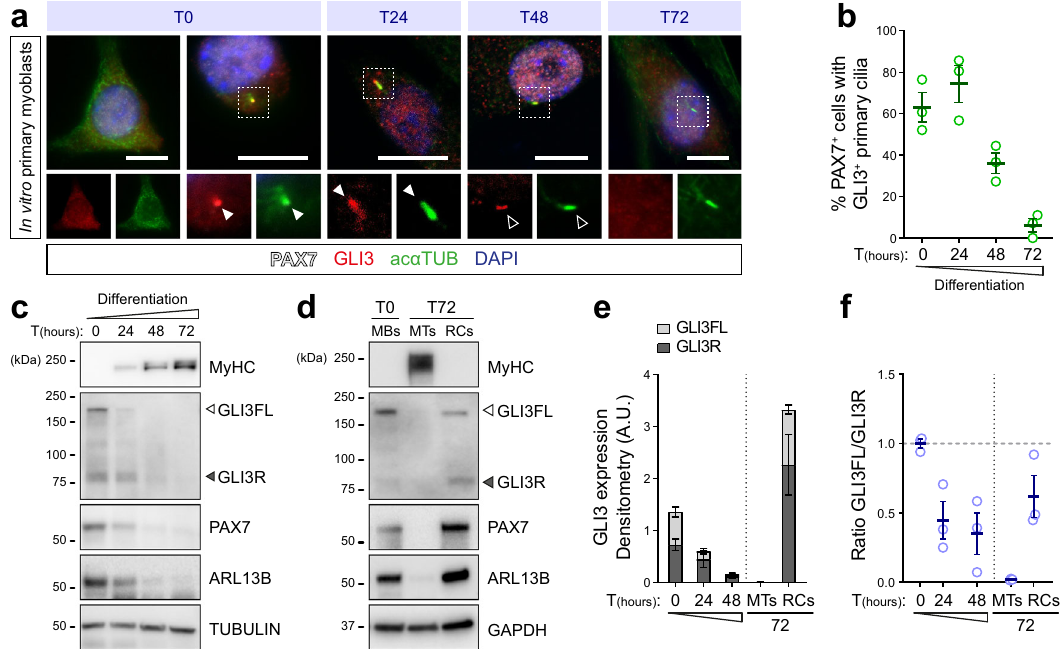
Fig. 2 GLI3 subcellular localization and proteolytic processing rely on primary cilia dynamics. a Immunostaining of GLI3 (red) in primary cilia labeled by acetylated α -TUBULIN (ac α TUB, green) of PAX7 + primary myoblasts (white) during their differentiation time course. White arrows indicate the tip of the primary cilium; empty arrows indicate the basal body. b Proportion of PAX7 + cells that display a GLI3 + primary cilium during myoblast differentiation time course ( n = 3 biologically independent samples). c Immunoblot analysis of GLI3 full-length (GLI3FL) and repressor (GLI3R) and the ciliary membrane marker ARL13B in proliferating myoblasts from 0 to 72 h of differentiation. PAX7 and MyHC (myosin heavy chain) are used to monitor myogenic differentiation. TUBULIN is used as a loading control. d Immunoblot analysis of ARL13B, GLI3FL, and GLI3R in myoblasts (MBs), 72 h-differentiated myoblasts or myotubes (MTs), and reserve cells (RCs). Both MBs and RCs express PAX7 while MTs express the myogenic differentiation marker MyHC. GAPDH is used as a loading control. e Densitometric analysis of the level of GLI3FL and GLI3R relative to TUBULIN signals of six ( − 24 h) and three biological replicates (0 – 72 h). f Ratio of GLI3FL/GLI3R relative to GAPDH ( − 24 h, n = 6 biological replicates; 0 – 72 h, n = 3 biological replicates). Scale bar, 10 µ m. Means ±